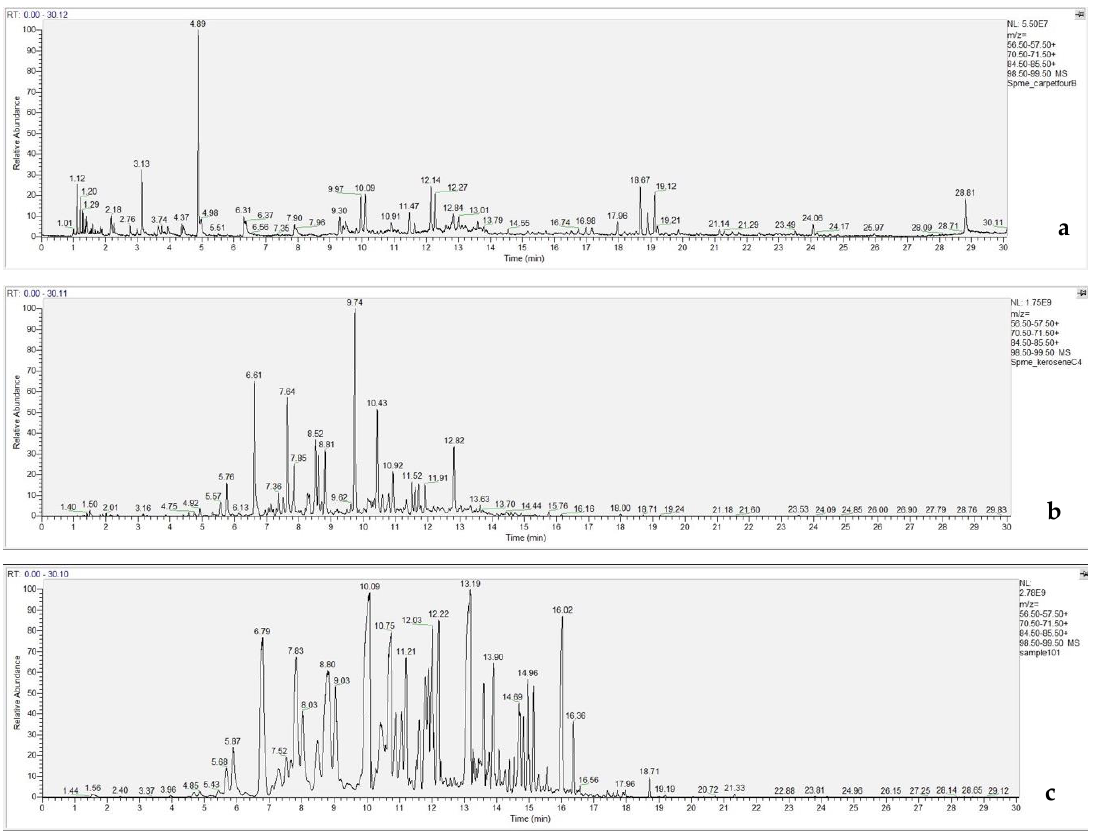
Figure 13. Extracted alkane profiles of ( a ) carpet #3 burned without ILs; ( b ) carpet #3 burned with